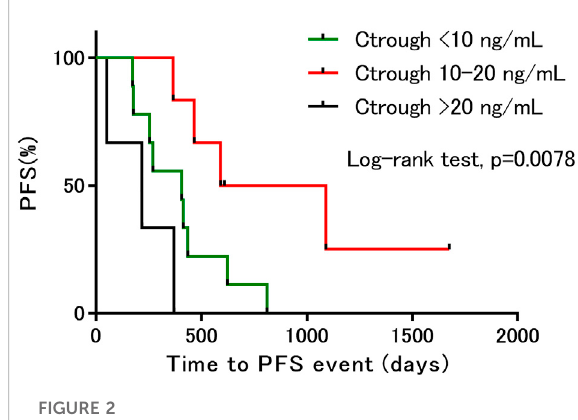
FIGURE 2 Kaplan – Meier estimates of progression-free survival, based on differences in trough concentration. PFS, progression free survival; C trough , trough